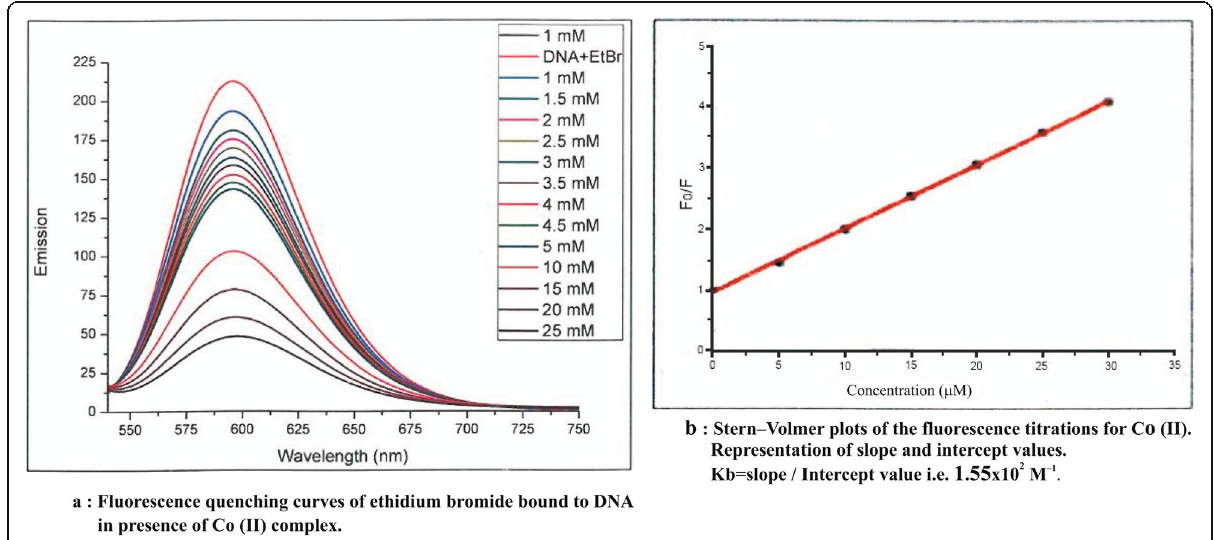
Fig. 9 a Fluorescence quenching curves of ethidium bromide bound to DNA in presence of Co (II) complex. b Stern-Volmer plots of the fluorescence titrations for Co (II) Complex. Representation of slope and intercept values. Kb = slope/Intercept value i.e. 1.55 × 10 2 M